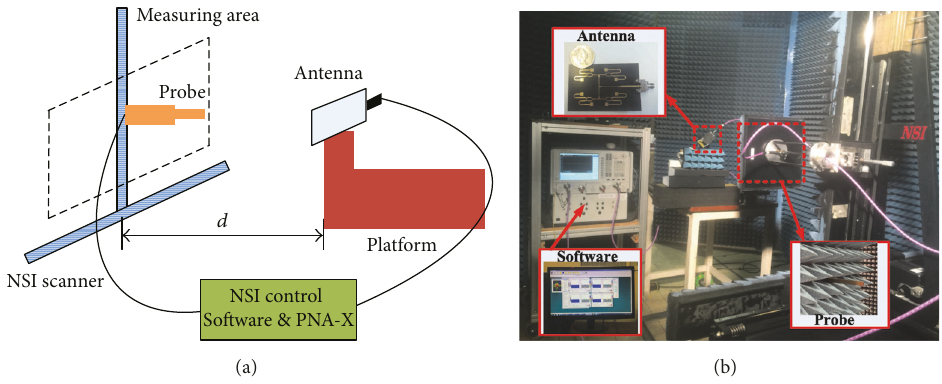
Figure 13: (a) Scheme of the measurement setup and (b) the picture of the measurement.